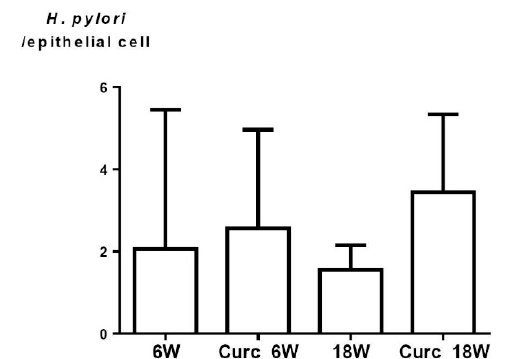
Figure 1. Gastric mucosa of an infected mouse. Immunohistochemistry for H. pylori , 40× (black arrows indicate bacteria) ( A ). Mucosal inflammation at 6 ( B ) and 18 weeks ( C ) of the infected non-treated mice (hematoxylin & Eosin (H & E) × 10). Black arrows indicate small lymphoid aggregates at the mucosa ( B ) and a well-defined lymphoyid aggregate at the submucosa ( C )—Normal gastric mucosa (H & E × 10) of infected mice treated with curcumin at 18 weeks ( D ).